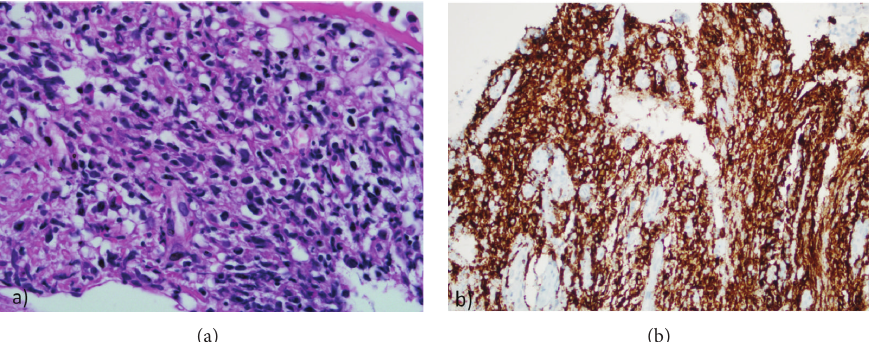
Figure 5: (a) Section shows an infiltrate of large atypical cells (H and E, × 400). (b) The neoplastic cells are diffusely CD20 positive (CD20 immunostain, × 400).